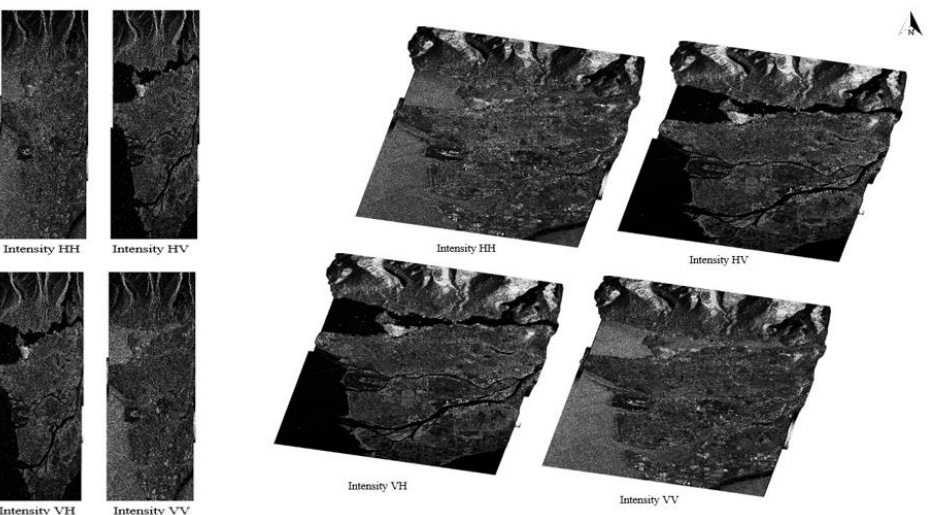
Figure 1. Intensities of HV, HH, VH and VV channels of PolSAR SLC data depicting the broader area of Vancouver, before and after preprocessing (radiometric calibration and geometric